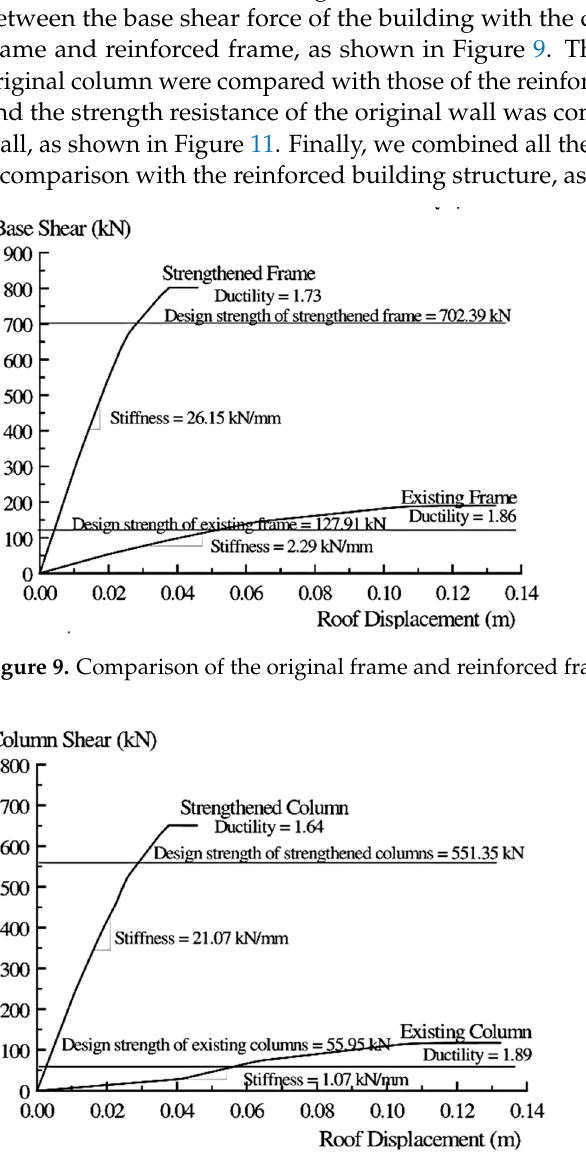
Figure 11. Comparison of the original walls and reinforced walls. Figure 12. Comparison of the original concrete building structure and reinforced concrete building structure. From Figure 9, we can see that the reinforced structure’s stiffness value is 26.15 kN/mm, and its strengthened value is 702.39 kN. By comparison, the original structure has a sti ff - ness value of 2.29 kN/mm and a strengthened value of 127.91 kN. For the reinforced struc- ture, the sti ff ness value and strengthened value are higher than those of the original struc- ture. The strengthened value di ff erence is approximately 14%.